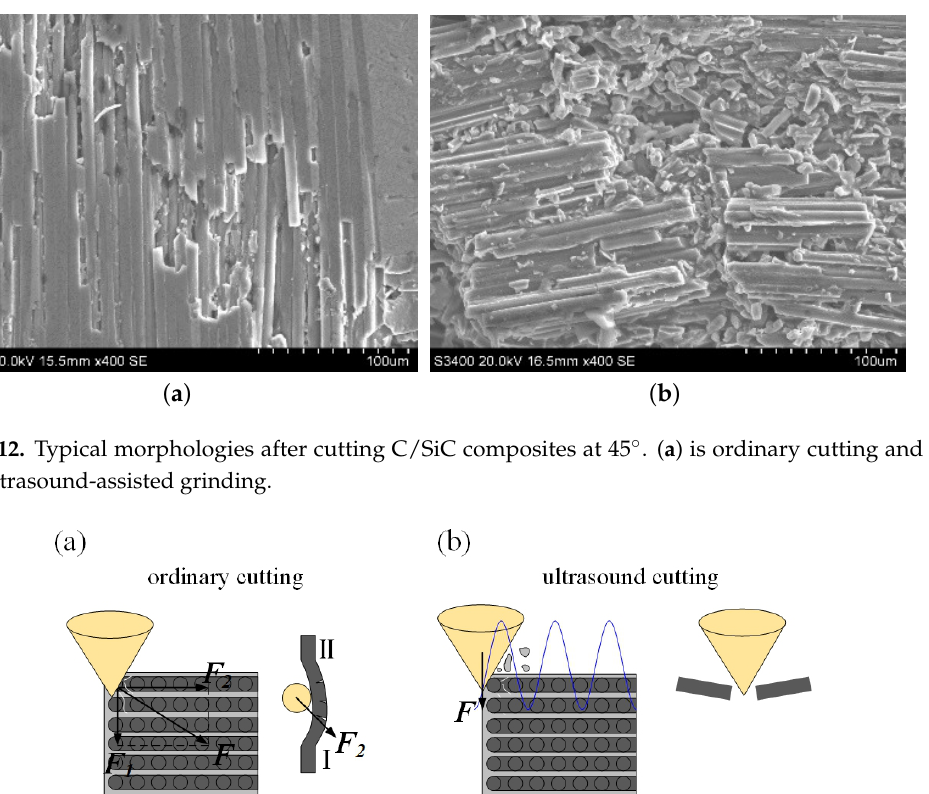
Figure 13. Comparison of material removal mechanisms between ordinary cutting and ultrasound cutting when the fiber orientation angle is 45 ◦ . ( a ) is ordinary cutting and ( b ) is ultrasound cutting.